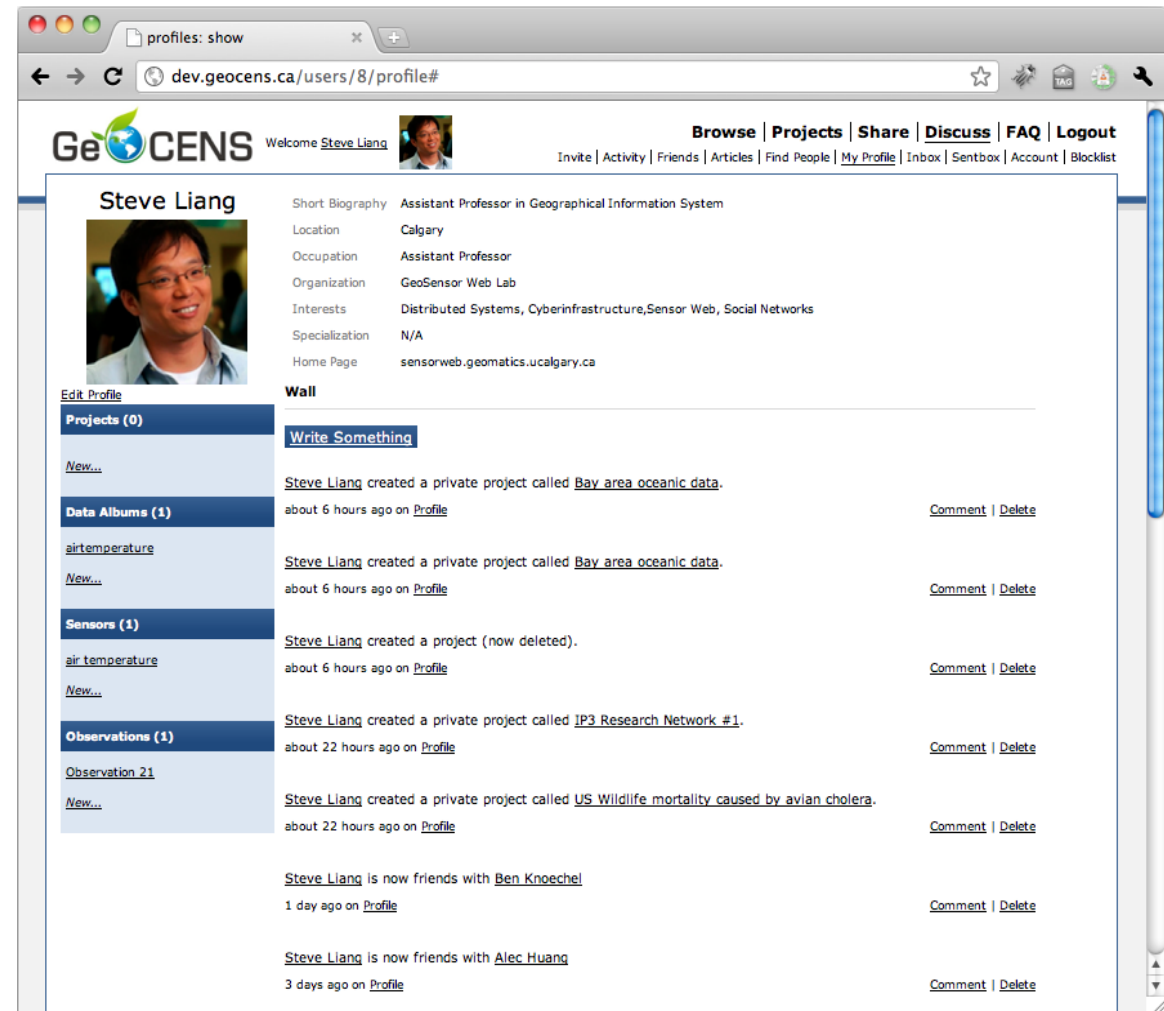
Figure 7. A screenshot of the GeoCENS online social